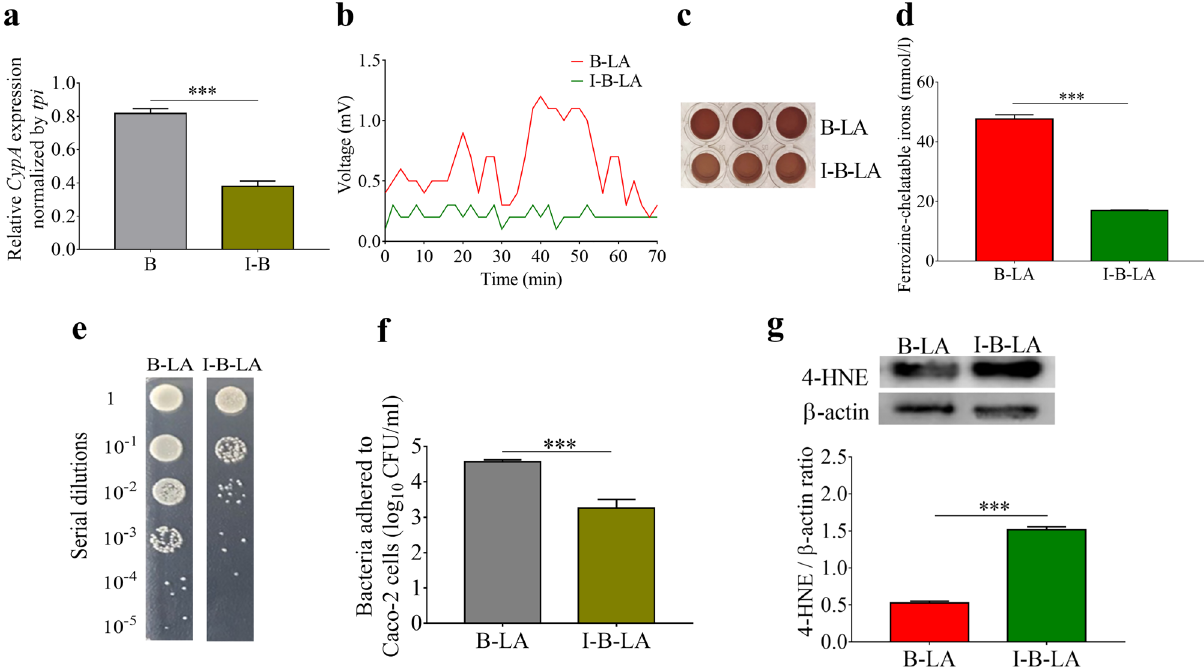
Figure 4. Requirement of L. mesenteroides EH-1 cyclophilin A for bacterial electricity and adhesion, as well as reduction of 4-HNE. ( a ) mRNA expression of cyclophilin A (CypA) in L. mesenteroides EH-1 pretreated with (I-B) or without TMN355 (B) was detected by real-time PCR. ( b ) Chronoamperometry results were obtained from an electrochemical chamber with L. mesenteroides EH-1 pretreated with (I-B-LA) or without (B-LA) TMN355 in the presence of linoleic acid. ( c ) Ferrozine and ferric ammonium citrate were added into media with L. mesenteroides EH-1 pretreated with or without TMN355 in the presence of linoleic acid. The dark brown complexes of ferrozine-chelatable irons were photographed. ( d ) The OD 562 values of ferrozine-chelatable irons (mmol/l) were quantified. ( e ) Adhesion of L. mesenteroides EH-1 pretreated with or without TMN355 in the presence of linoleic acid on Caco-2 cells. Bacterial CFUs were counted by plating serial dilutions (1 ∶ 10 0 to 1 ∶ 10 5 ) of Caco-2 cells with adherent bacteria on a TSB agar plate and ( f ) the number (log 10 CFU/ml) of adherent bacteria was shown. ( g ) The 4-HNE production in abdominal fats in mice administered L. mesenteroides EH-1 plus linoleic acid (B-LA) or TMN355-pretreated bacteria plus linoleic acid (I-B-LA) was examined. The levels of 4-HNE and β-actin in abdominal fat mass were detected by western blot analysis. The ratio intensities of 4-HNE to β-actin were quantified by Image J software. Full-length western blot images were presented in Fig. S5. Data shown represent the mean ± SD of experiments performed in triplicate. *** p < 0.001 (two-tailed t -test by GraphPad Prism